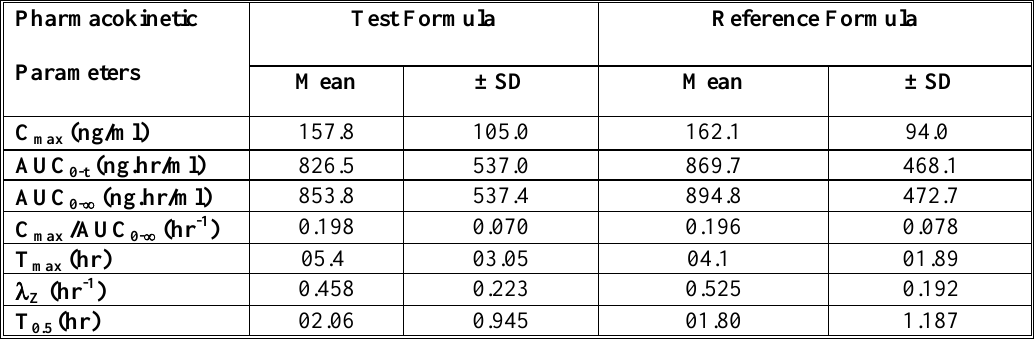
Table (4): Pharmacokinetic parameters of pentoxifylline after a single dose administration of a test formulation (extended- release tablet containing 400 mg pentoxifylline) and the reference formulation (Trental ® extended-release tablet containing 400 mg pentoxifylline) to 32 healthy male adult subjects under fed condition. Mean ± SD.